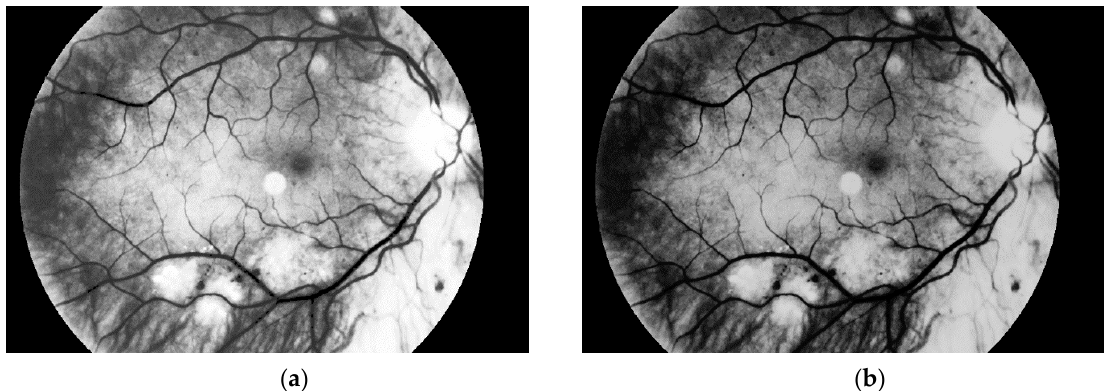
Figure 11. Image after ( a ) histogram equalization and ( b ) after brightness correction.